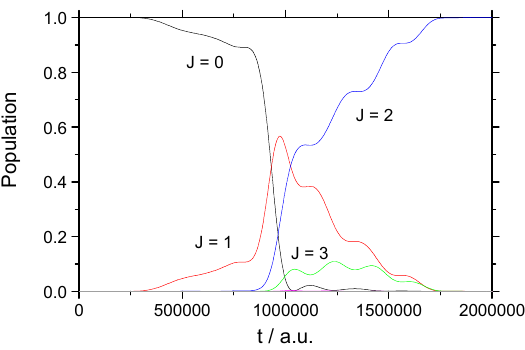
Figure 2. Temporal changes in state populations for the rotational excitation, ( v = 0, J = 0) → ( v = 0, J = 2), in the weak-field regime: (a) vibrational states; (b) rotational states. Table 3. Comparison of the yields with the full ( Ĥ 0 + Ĥ 1 + Ĥ 2 ) and partial Hamiltonians ( Ĥ 0 + Ĥ 1 and Ĥ 0 + Ĥ 2 ), obtained using the optimal fields for the full Hamiltonian. Init. Guess